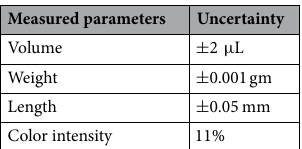
Table 3. Specification of the measurements.